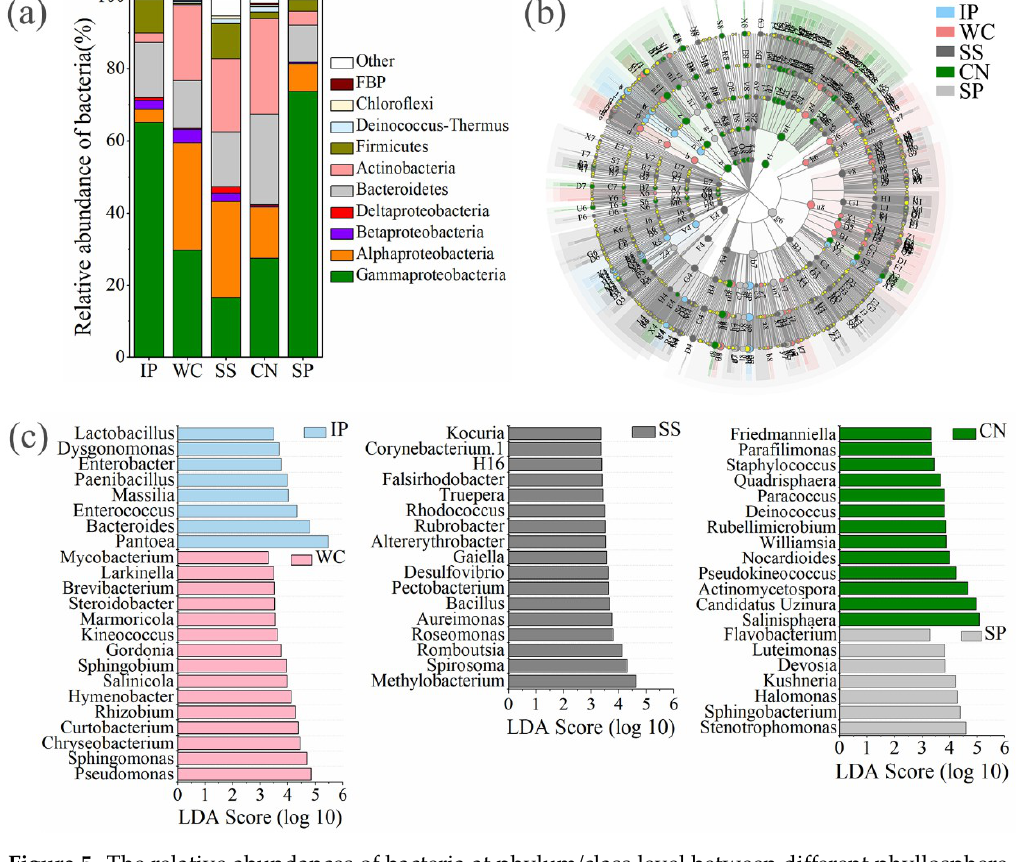
Figure 5. The relative abundances of bacteria at phylum/class level between different phyllosphere samples ( a ). Taxonomic differences among different phyllosphere samples by a linear discriminant analysis (LDA) coupled with effect size (LEfSe). Taxonomic representation of statistically and biologically consistent differences among different phyllosphere samples ( b ). LDA scores were calculated by the LDA effect size, using the linear discriminant analysis to assess the effect size for each differential genera with relative abundance of the taxa comprising more than 0.5% of the bacterial sequences in each sample ( c ). IP indicates Ipomoea pes-caprae , WC indicates Wedelia chinensis , SS indicates Scaevola sericea , CN indicates Cocos nucifera , SP indicates Sesuvium portulacastrum .